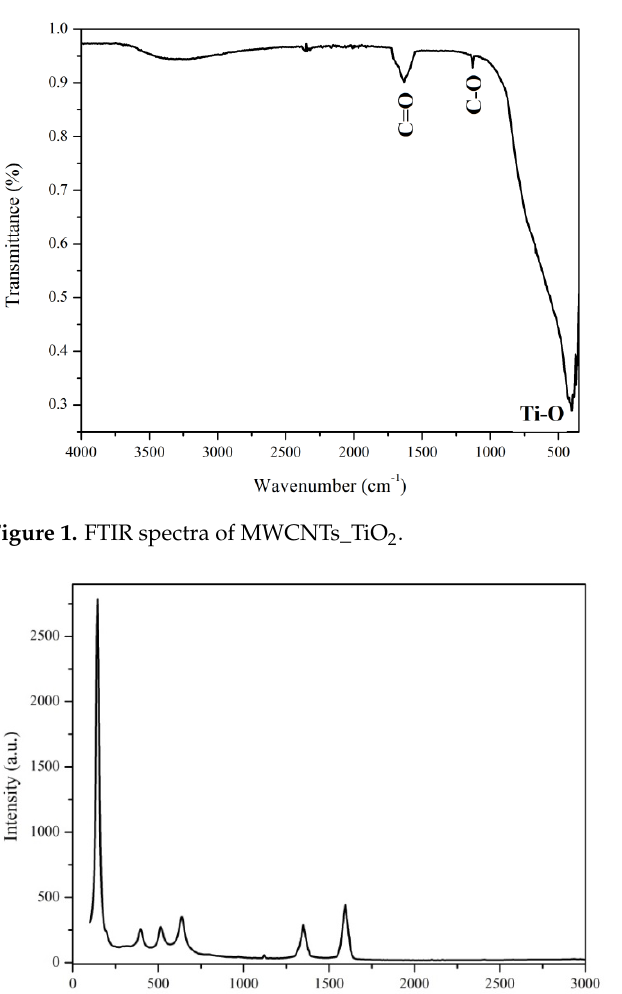
Figure 1. FTIR spectra of MWCNTs_TiO 2